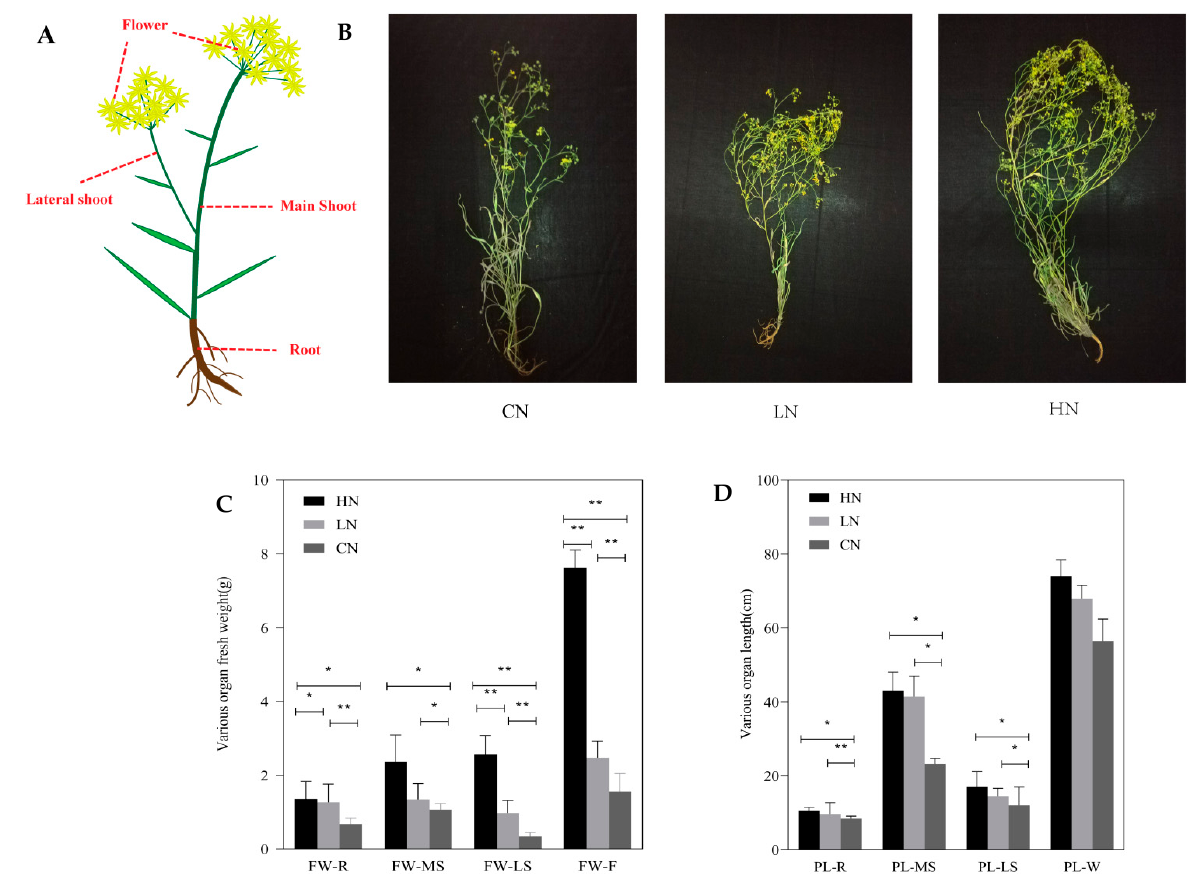
Figure 1. Growth performances of Bupleurum at three nitrogen fertilization levels within four organs. ( A ) The whole Bupleurum was divided into four organs, including root, main shoots, lateral shoots and flower; ( B ) Appearances of Bupleurum growing under CN, LN and HN, respectively; ( C ) The four organs’ fresh weights (n = 3); ( D ) The length of the whole plant and the different parts (n = 3). Three nitrogen fertilization levels—CN: control nitrogen group, LN: low-nitrogen group, and HN: high-nitrogen group; four organs—R: root, MS: main shoots, LS: lateral shoots, F: flower, and W: whole plant. * and ** signify significant ( p < 0.05) and extremely significant ( p < 0.01), respectively.